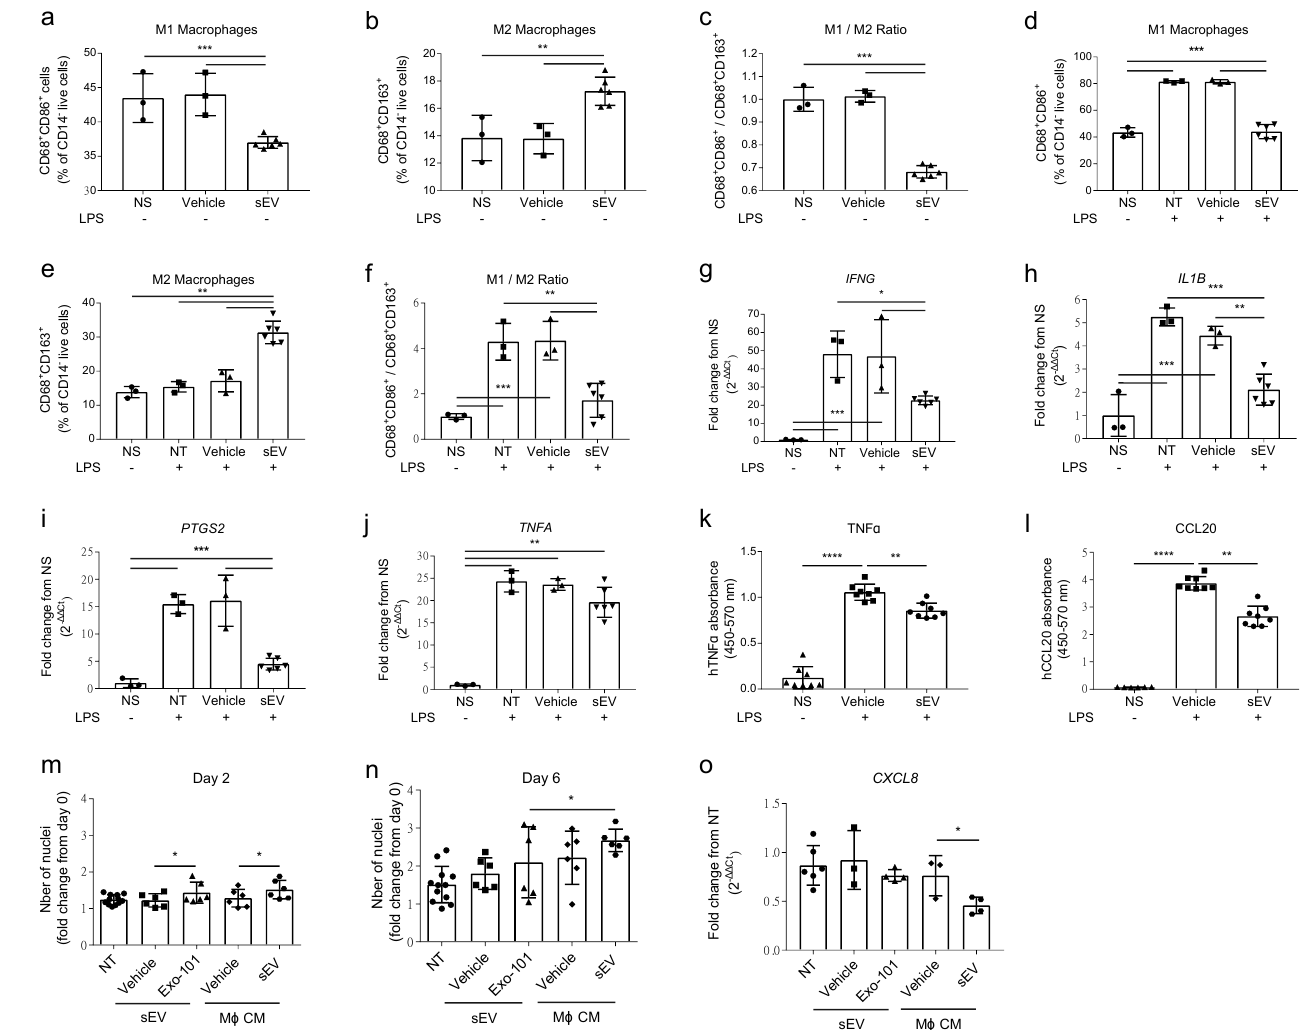
Figure 1. UCB-MNC-sEV’s immunomodulatory effects in vitro. ( a – f ) THP-1-derived macrophages, with or without LPS stimulation as indicated, were incubated with 1 × 10 10 particles/mL of UCB-MNC-sEV for 24 h, before flow cytometry analysis ( n ≥ 3). ( g – j ) Relative expression of M1-associated genes by qPCR ( n ≥ 3) and ( k , l ) release of pro-inflammatory molecules by ELISA ( n ≥ 6). ( m , n ) Proliferation of normal human dermal fibroblasts, 2 and 6 days after incubation with UCB-MNC-sEV (1 × 10 10 particles/mL) or media from UCB-MNC-sEV-stimulated macrophages ( n ≥ 6), and ( o ) CXCL8 expression at 48h ( n ≥ 3). All results are presented as mean ± SD. * p ≤ 0.05, ** p ≤ 0.01, *** p ≤ 0.001, **** p ≤ 0.0001. NS, non-stimulated; NT, non-treated; CM, conditioned